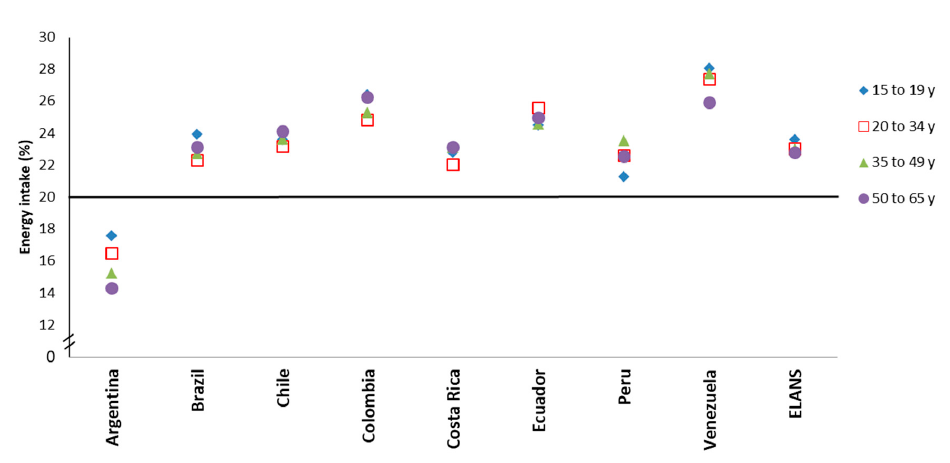
Figure 2. Contribution of breakfast to daily EI (%) among occasional and regular consumers by country. EI: energy intake. The 20% cutoff is indicated by a solid black line.